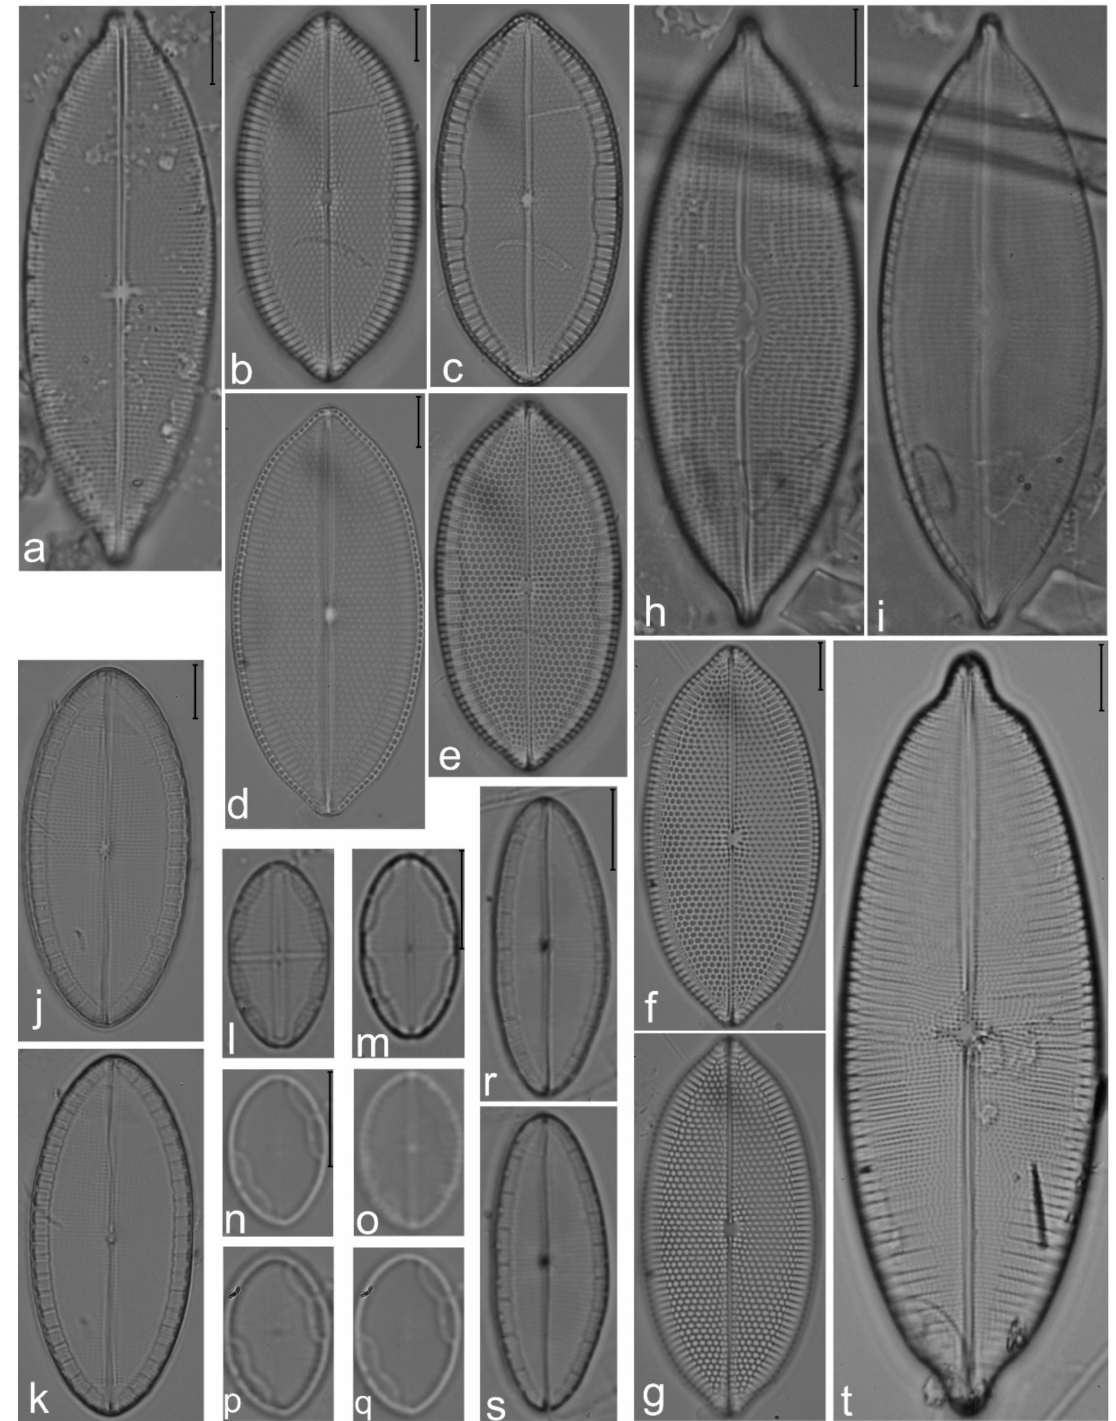
Figure 19. ( a ) Mastogloia cf. elegans ; ( b – g ) M . angulata in different focal planes; ( h , i ) M . lineata var. albifrons ; ( j , k ) M . ovata ; ( l , m ) M . crucicula var. crucicula ; ( n – q ) M . crucicula var. alternans ; ( r , s ) M . ovulum ; ( t ) Mastoneis biformis . Scale bar = 10 µ